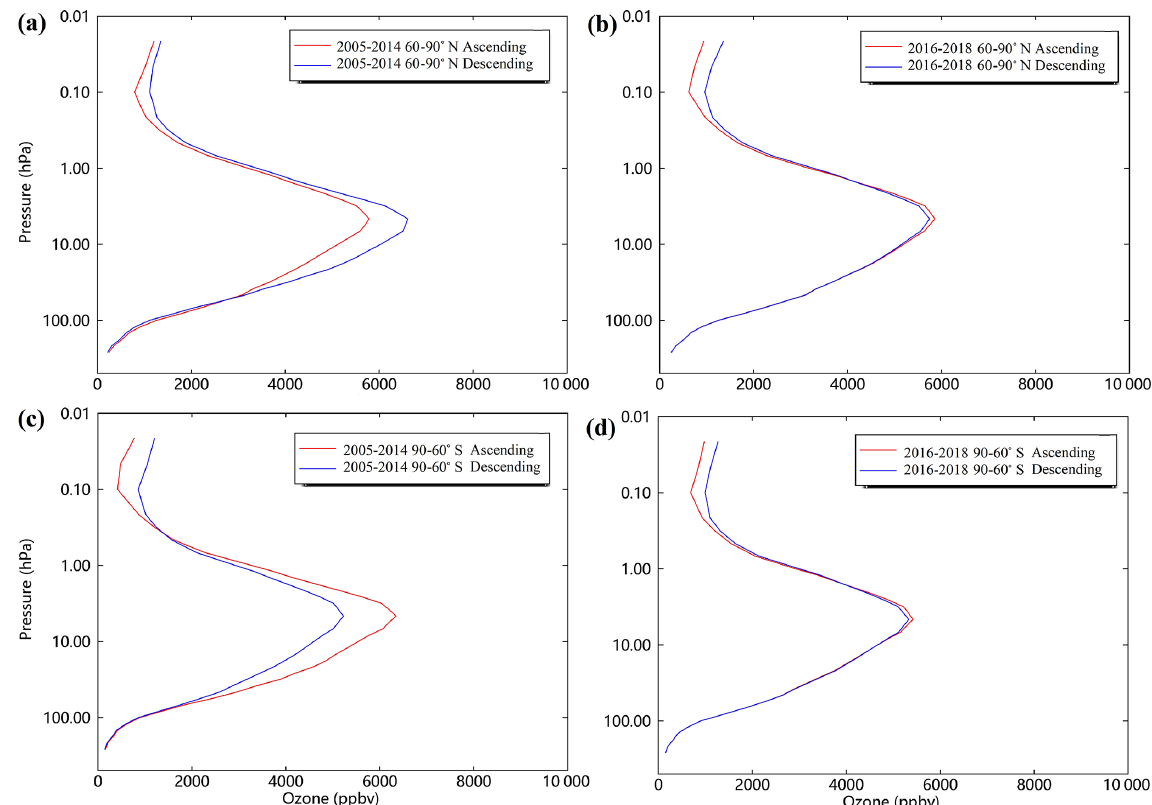
Figure 4. (a) Averaged MLS ozone profile between 261 and 0.02hPa for 2005–2014 from 60 to 90 ◦ N. (b) Averaged MLS ozone profile between 261 and 0.02hPa for 2016–2018 from 60 to 90 ◦ N. Panels (c) is the same as panel (a) but for 90–60 ◦ S. Panel (d) is the same as panel (b) but for 90–60 ◦